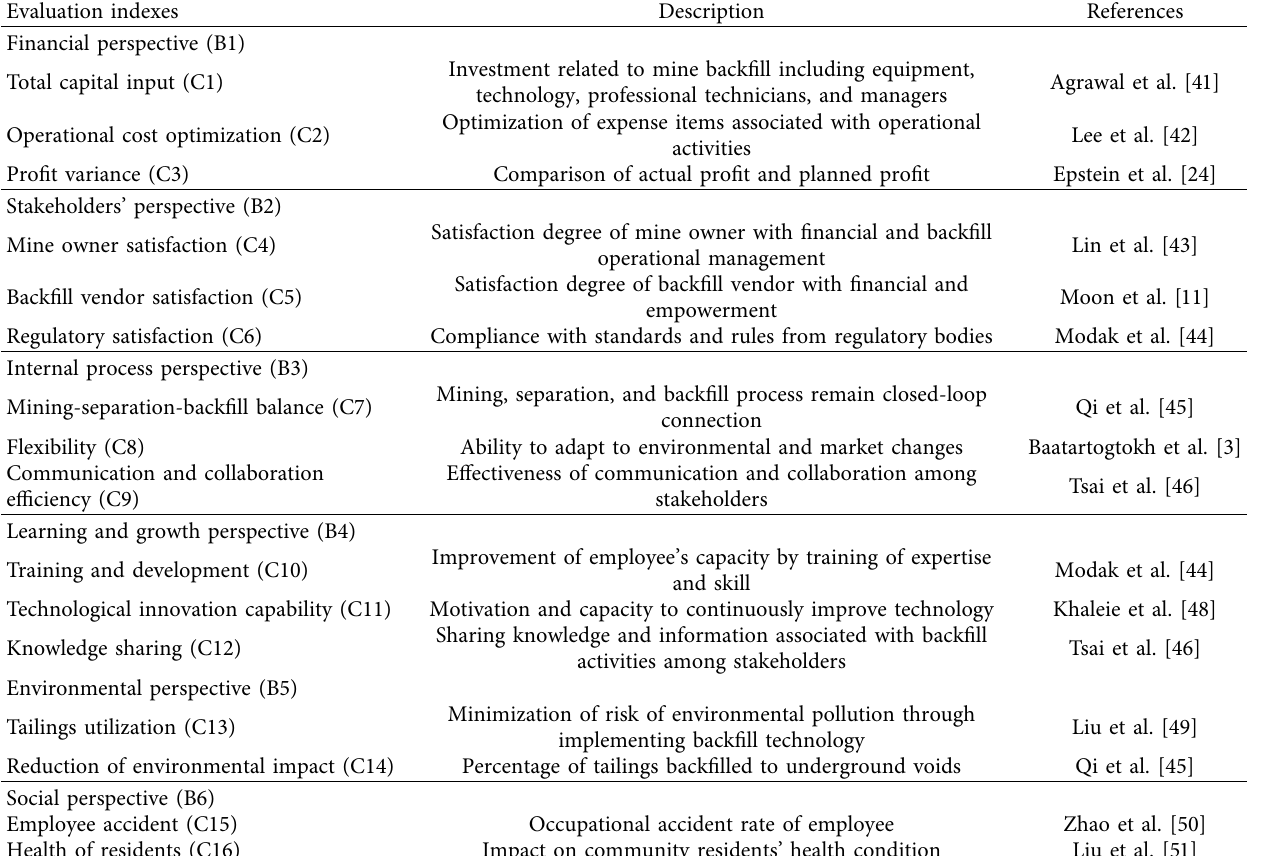
Table 1: Description of evaluation